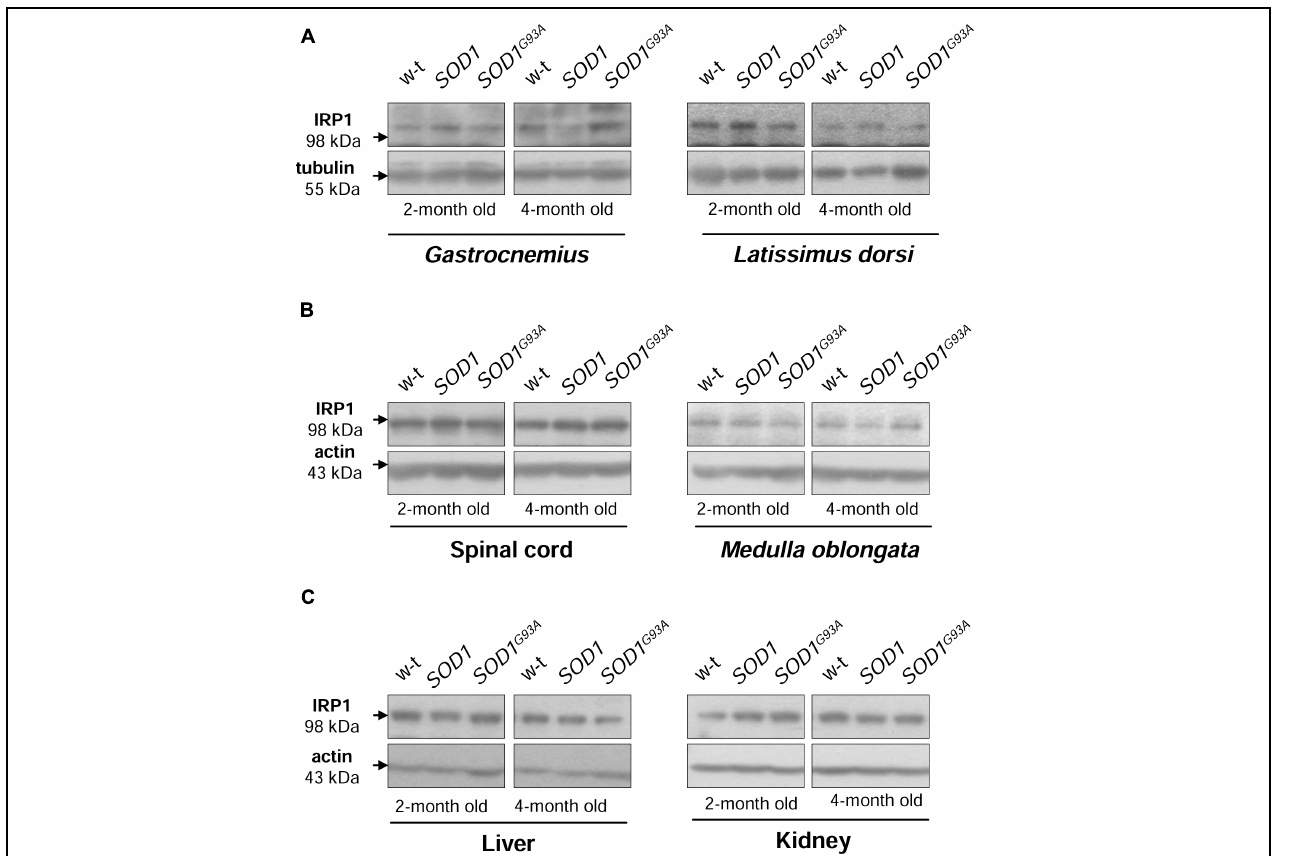
FIGURE 4 | Wild-type, SOD1 and SOD1 G 93 A mice show similar IRP1 protein levels in all examined tissues. IRP1 levels were assessed in total skeletal muscle (A) , neuronal tissues (B) , hepatic and renal (C) extracts by Western blotting as described under “Material and Methods”. Blots were also re-probed with monoclonal anti-tubulin or anti- β -actin antibodies from mouse as a loading control. Data are representative for three independent Western blot analyses performed using extracts from 3 mice of each experimental group. The intensity of the IRP1 bands (relative to the intensity of tubulin or actin bands) was quantified with a Molecular Imager using Quantity One software (Bio-Rad) and is shown in arbitrary units to present protein level (Supplementary